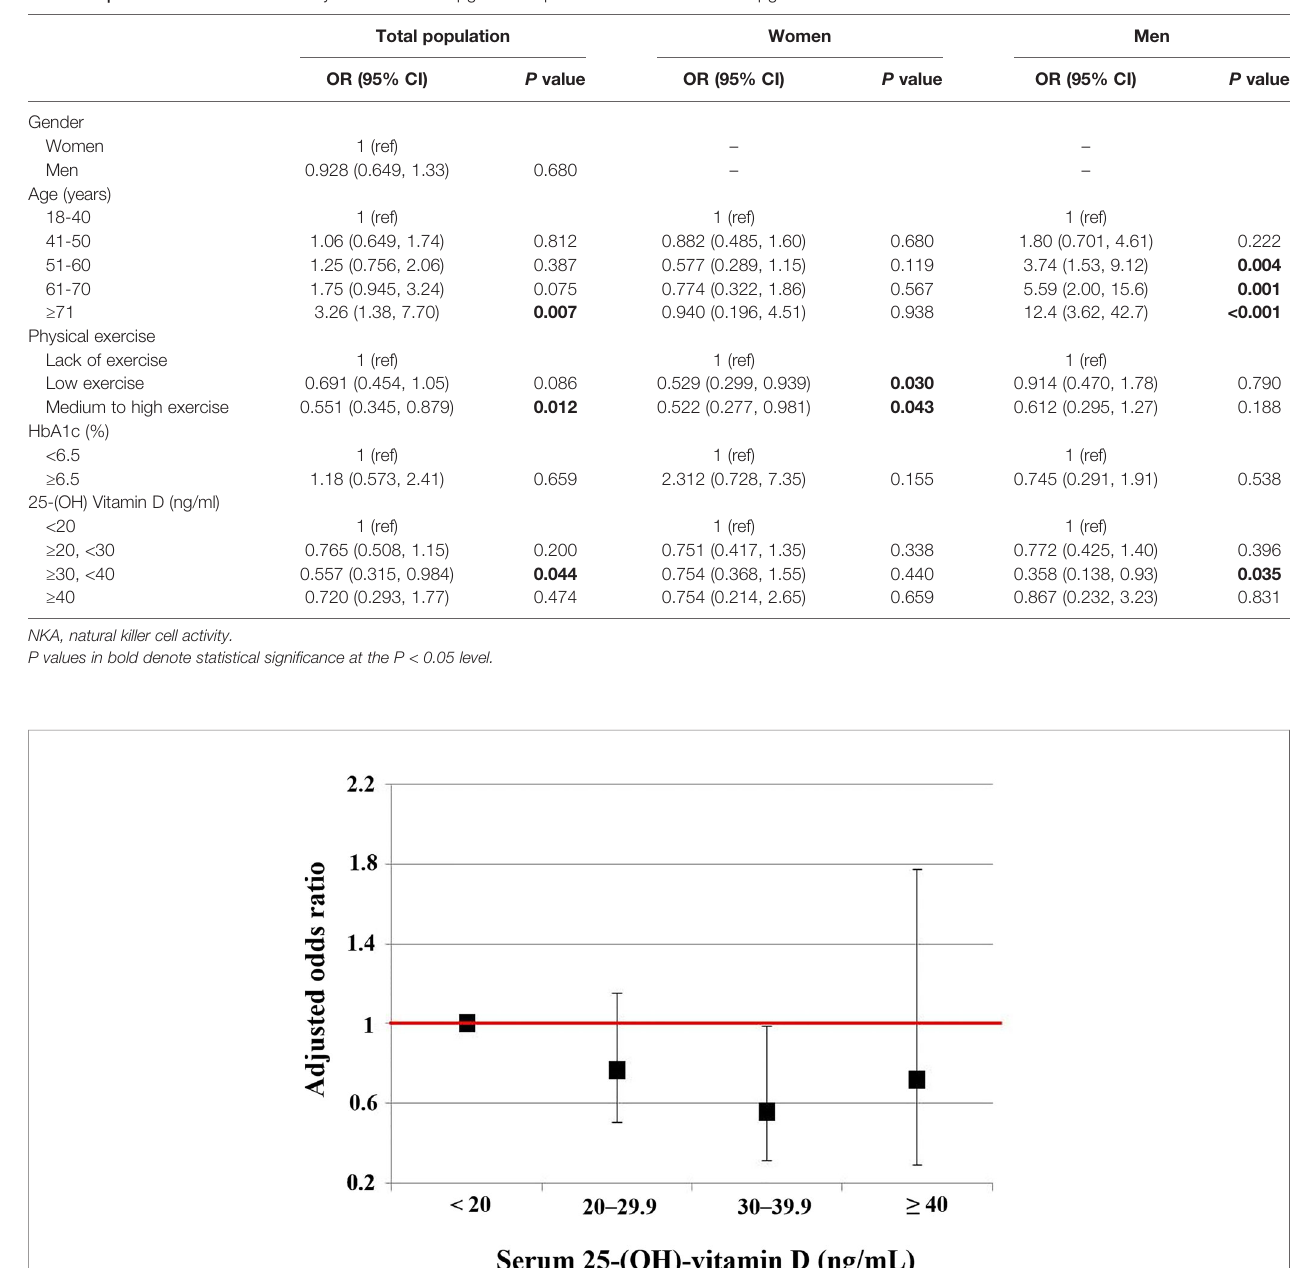
TABLE 2 | Factors associated with very low NKA < 100 pg/mL compared to normal NKA ≥ 500 pg/mL.